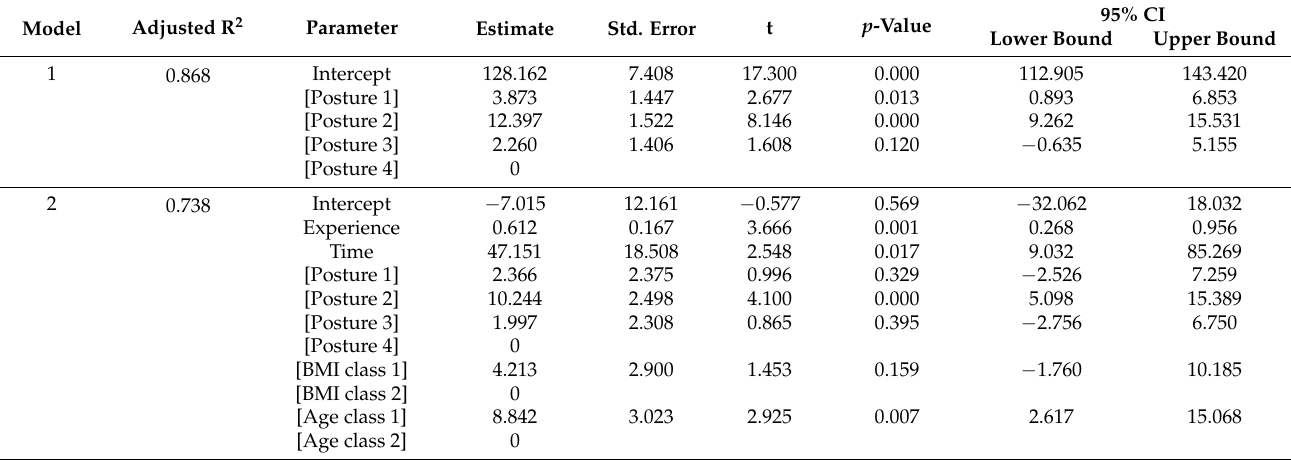
Table 8. Goodness-of-fit and parameter estimates for the general linear models of the